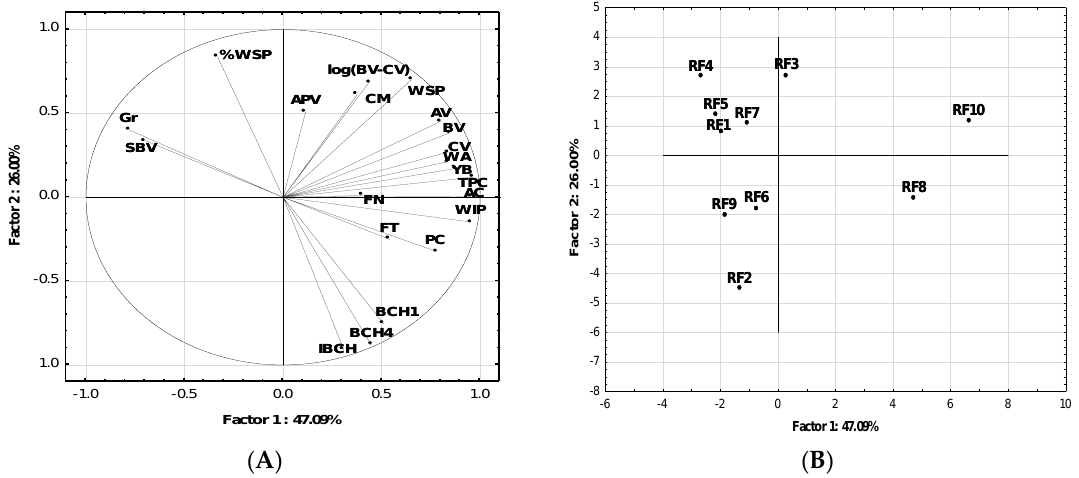
Figure 1. Principal component analysis: ( A ) Loading plot of PC1 and PC2 for the evaluated parameters of the tested rye flours and breads; ( B ) score plot of PC1 and PC2 for tested rye flours.